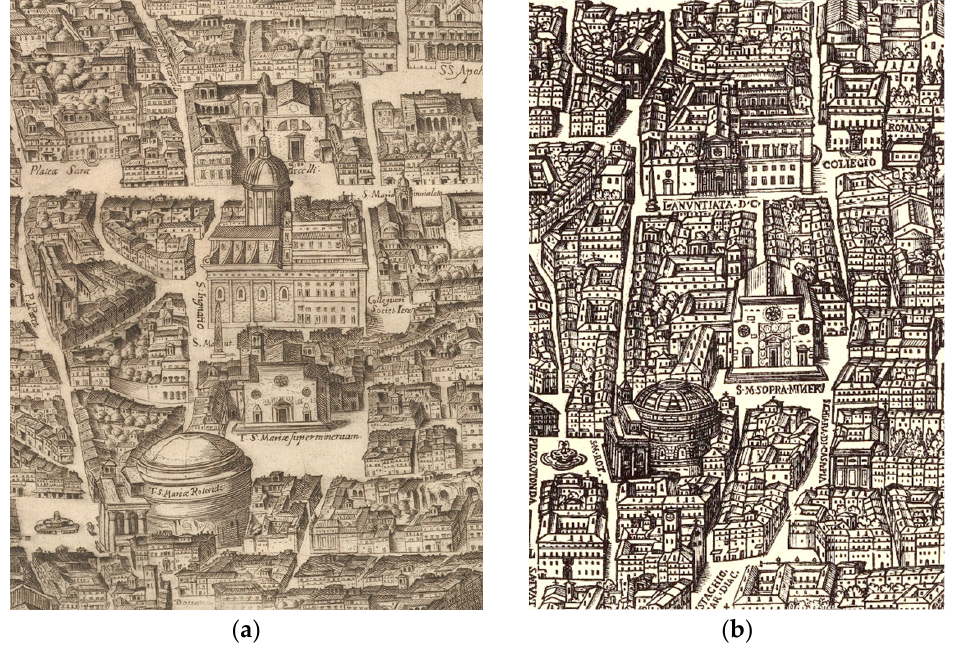
Figure 3. ( a ) Antonio Tempesta, Plan of the City of Rome ed. 1645 by Giovanni Domenico de Rossi, The Metropolitan Museum Edward Pearce Casey Fund, 1983 (Accession